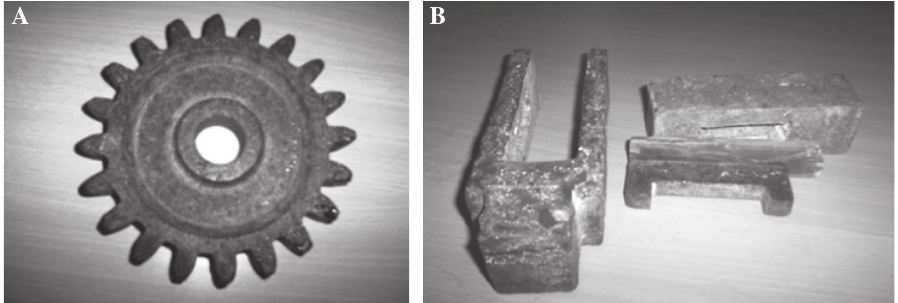
Figure 11: (A) Spur gear and (B) gib-cotter joint fabricated by roselle fiber/polyester [4].